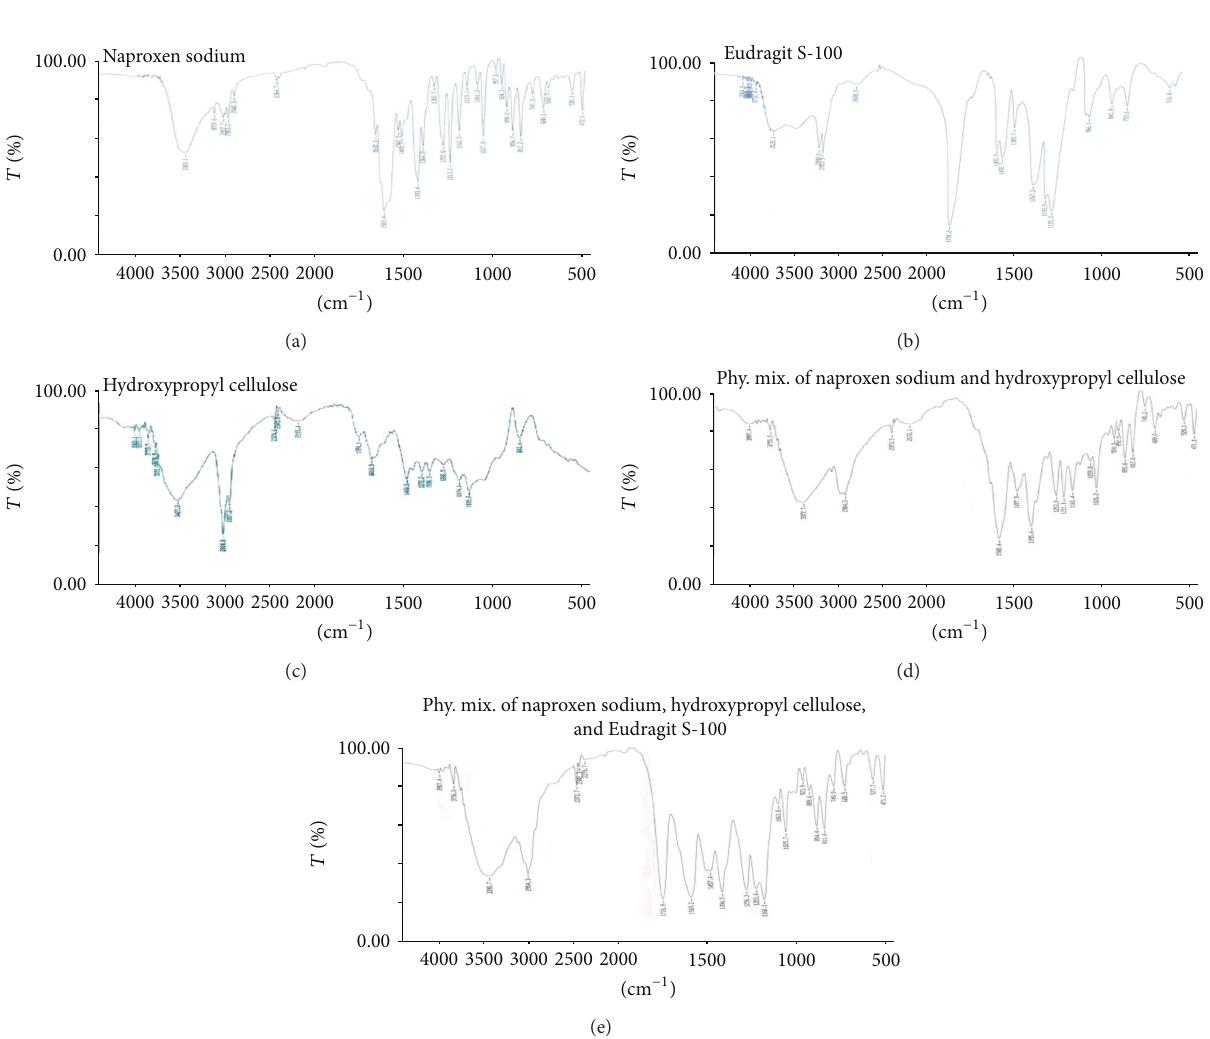
Figure 1: Fourier transform infrared spectra of naproxen sodium, Eudragit S-100, hydroxypropyl cellulose, physical mixture (naproxen sodium and hydroxyl propyl cellulose), and physical mixture (naproxen sodium, hydroxyl propyl cellulose, and Eudragit